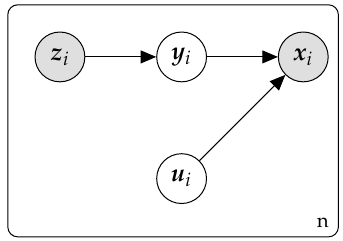
Figure 1. Bayesian dependency graph for factorial discriminant